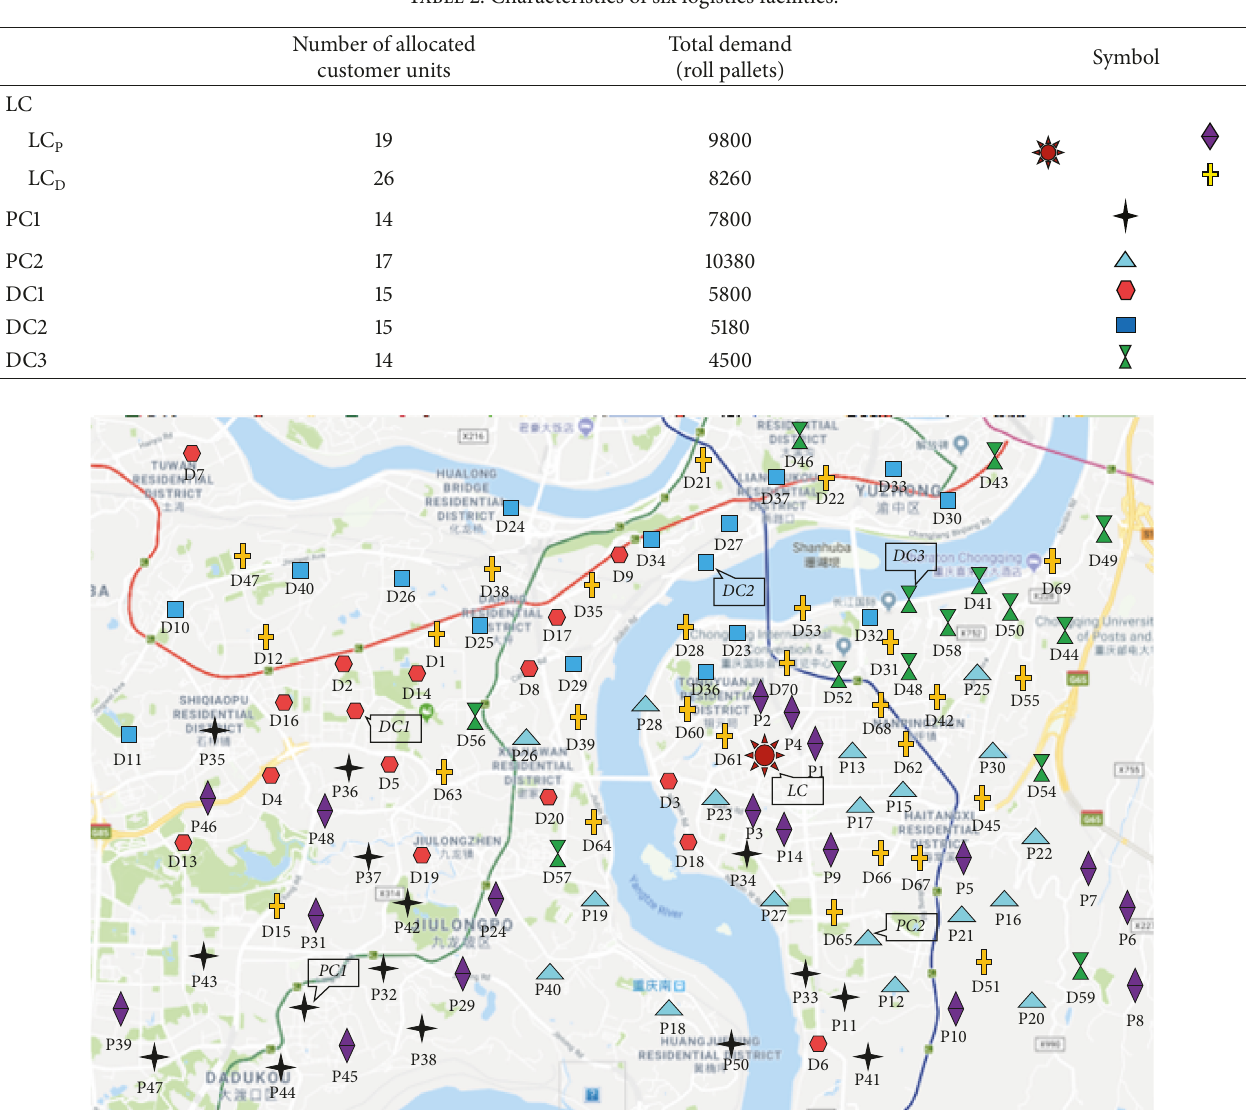
Figure 4: Pickup and distribution centers and units distribution